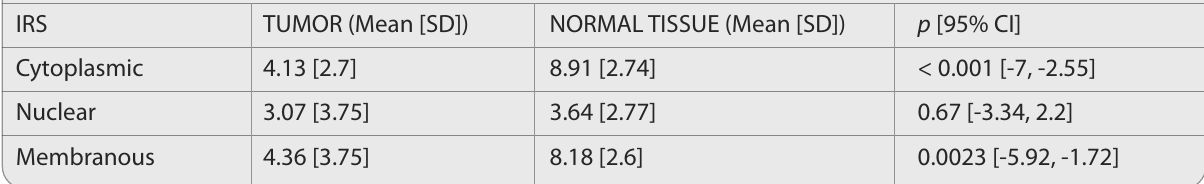
Table 1. Average values of final Immunoreactive Score (IRS) for CYLD expression in every cell compartment (cell membrane, cytoplasm and nucleus) of tumor cases and normal renal tissue ( p - values were calculated using un- paired t-test). CI: Confidence